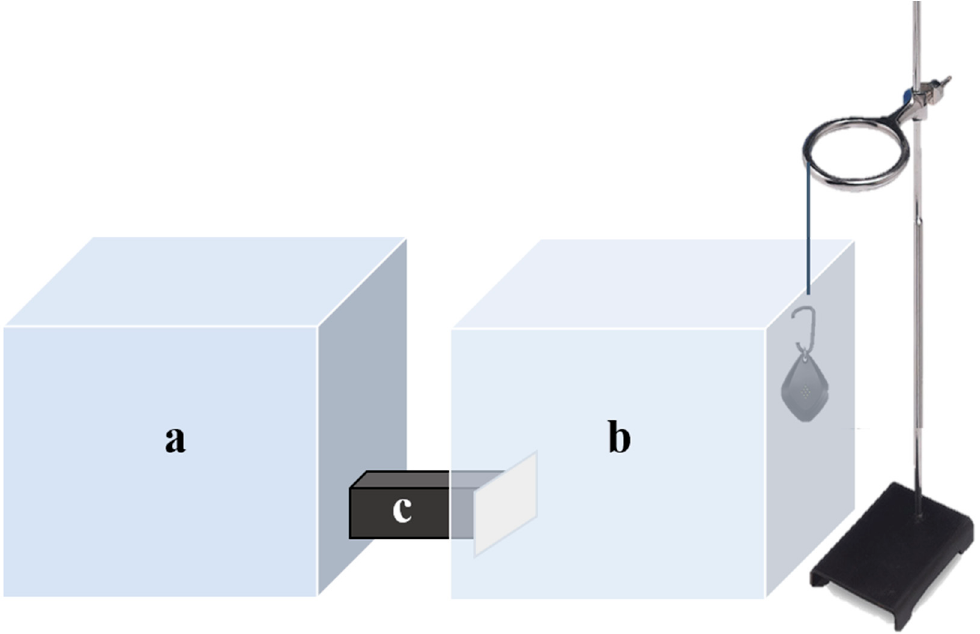
Figure 1. The test chambers used in the trials. The escape chamber ( a ) connected the test chamber ( b ) by a cardboard corridor ( c ). For the treatment, ultrasonic device was suspended at a height of 20 cm within test chambers by using a ring stand and the other as a control (no ultrasonic device).